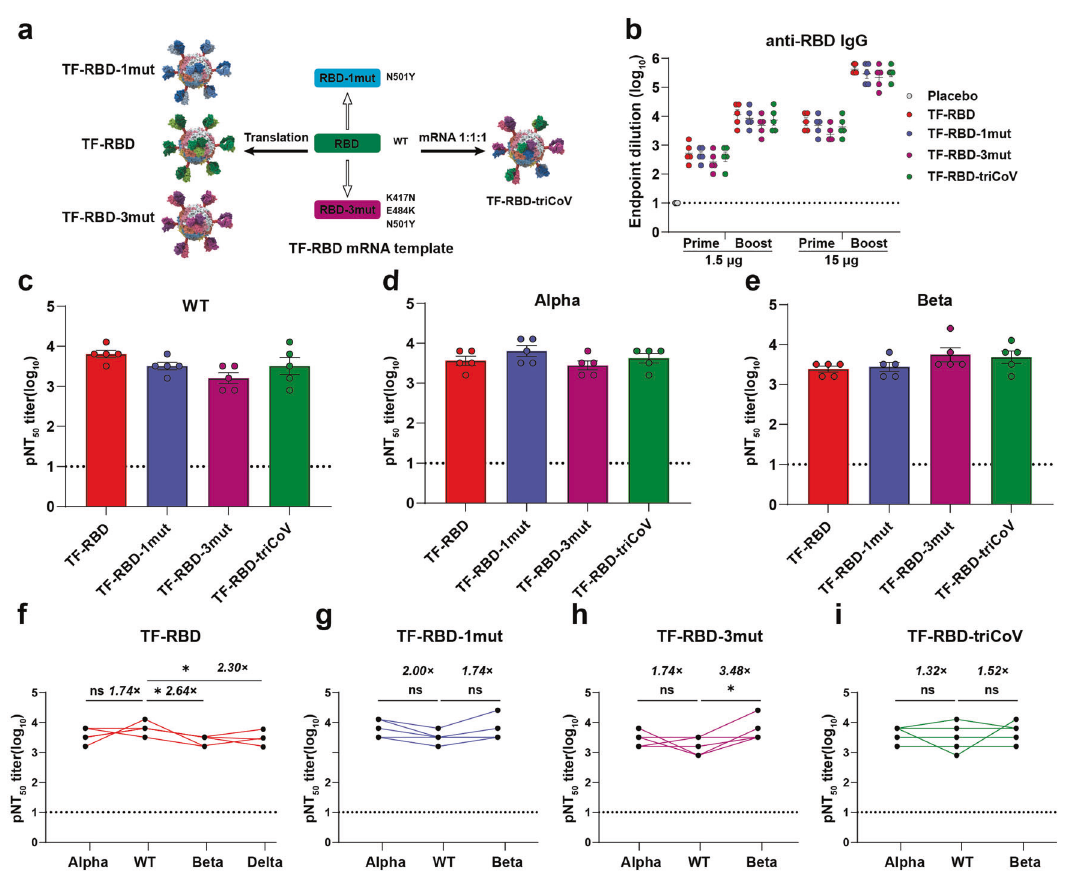
Fig. 5 The trivalent TF-RBD (TF-RBD-triCoV) mRNA vaccine candidate enhances cross-neutralization. a Schematic diagram of the TF-RBD- triCoV mRNA vaccine. TF-RBD-triCoV contains TF-RBD, TF-RBD-1mut (N501Y), and TF-RBD-3mut (K417N, E484K, N501Y) mRNA with mass ratio of 1:1:1. b Groups of 6- to 8-week-old female naive C57BL/6 mice ( n = 5) were vaccinated by secondary immunization at 2-week intervals. The RBD-speci fi c IgG titer of SARS-CoV-2 was revealed by ELISA. c – e Pseudovirus neutralization assay of the 1.5- μ g dose group shows the NT 50 values for the WT virus ( c ), variant Alpha ( d ), and variant Beta ( e ). f – i Changes in the serum neutralization titers of each vaccine in the 1.5- μ g dose group against different pseudoviruses. The following cross-NAb titers are demonstrated: TF-RBD ( f ), TF-RBD-1mut ( g ), TF-RBD-3mut ( h ), and TF-RBD-triCoV ( i ). The dotted horizontal lines indicate the limits of quanti fi cation for the ELISA and NAb titers. The data are shown as the mean ± SEM. P values were determined by one-way ANOVA (ns, p > 0.05; * p < 0.05; ** p < 0.01; *** p < 0.001; **** p < 0.0001). See also Figures S5 and